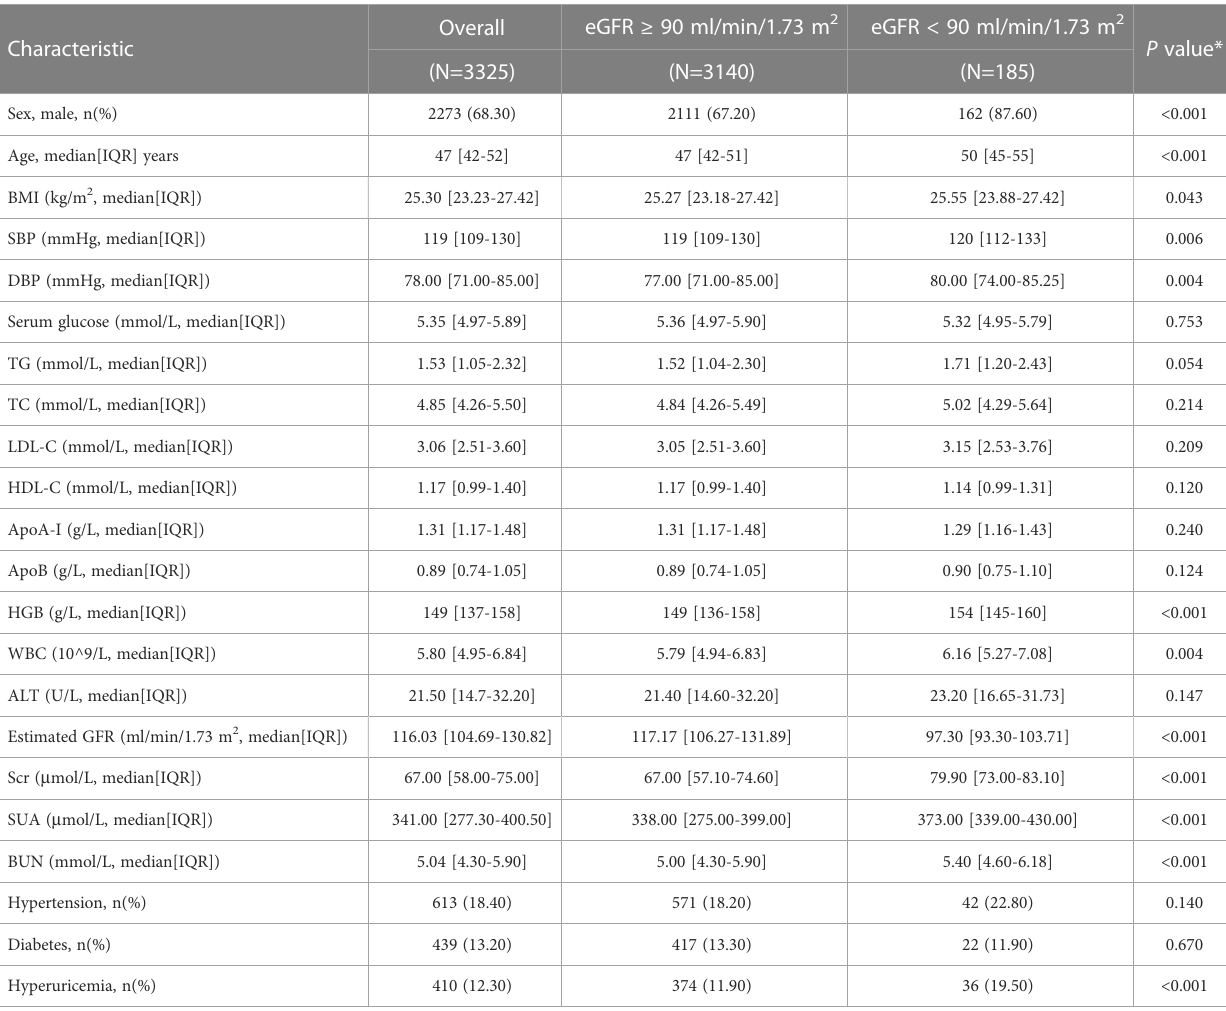
TABLE 3 Baseline characteristics of the longitudinal